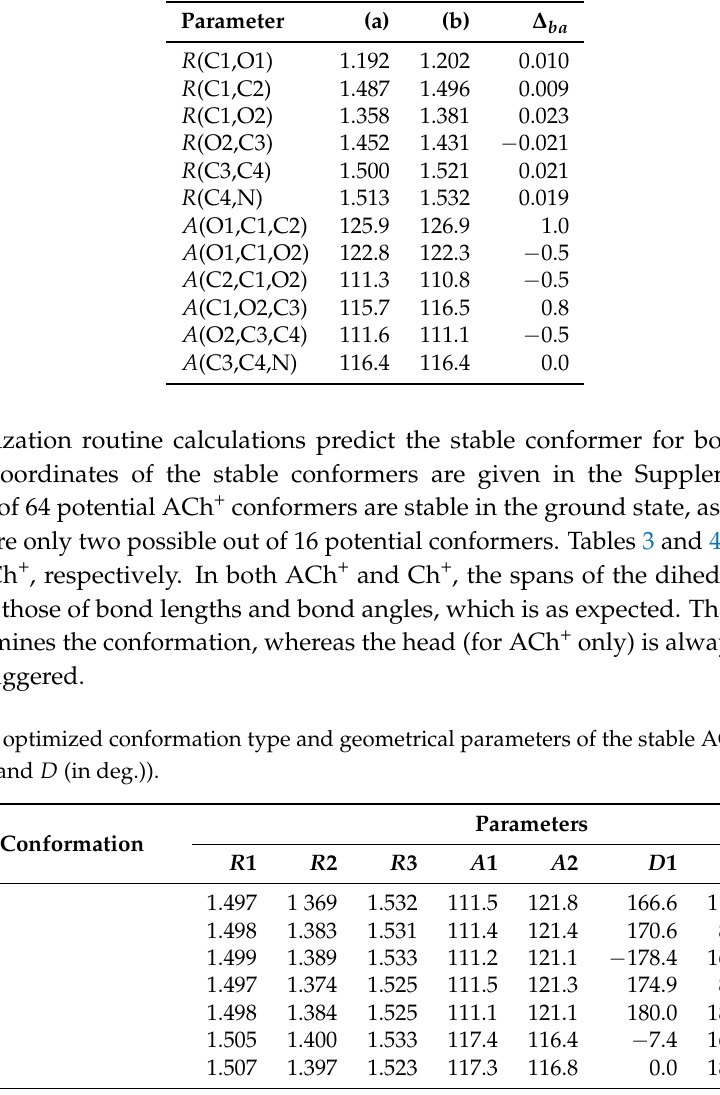
Table 2. The optimized geometrical parameters of ACh + Br – from (a) experimental values [29] and (b) our calculations (R (in Å); A (in deg.)). The discrepancy ∆ ba is the value of (b) minus (a).